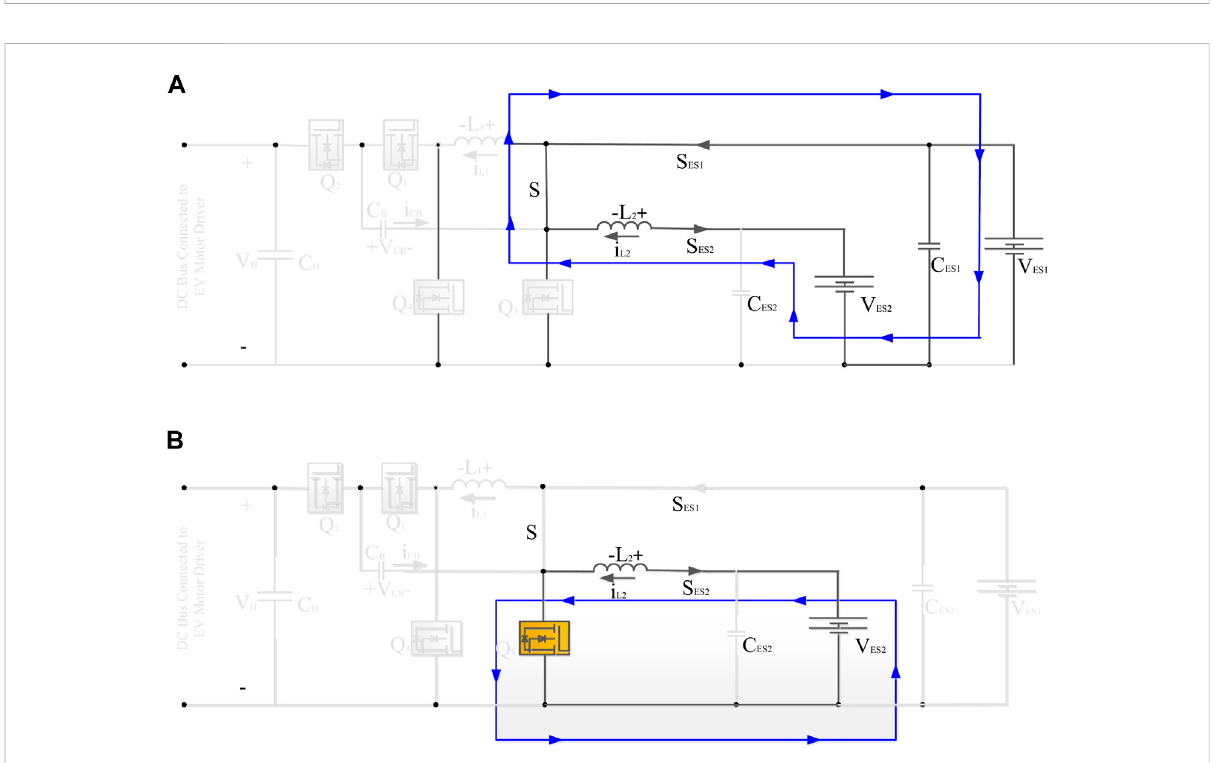
FIGURE 9 The suggested BDCC circuit states for the low voltage dual-source boost mode (A) level 1 and (B) level